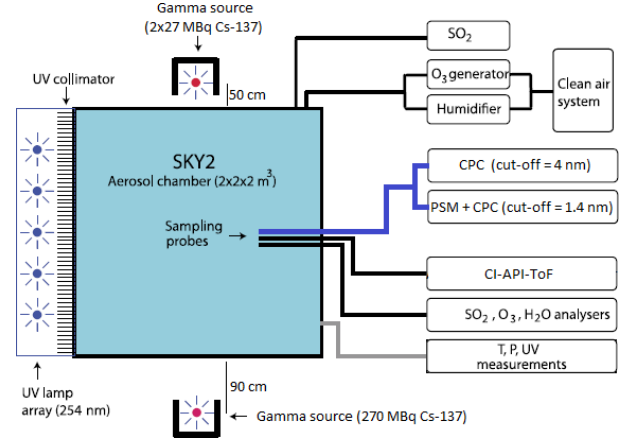
Figure 1. A schematic of the SKY2 reaction chamber and the in- struments used for the experiment. The figure is an edited version of the schematic from Svensmark et al.